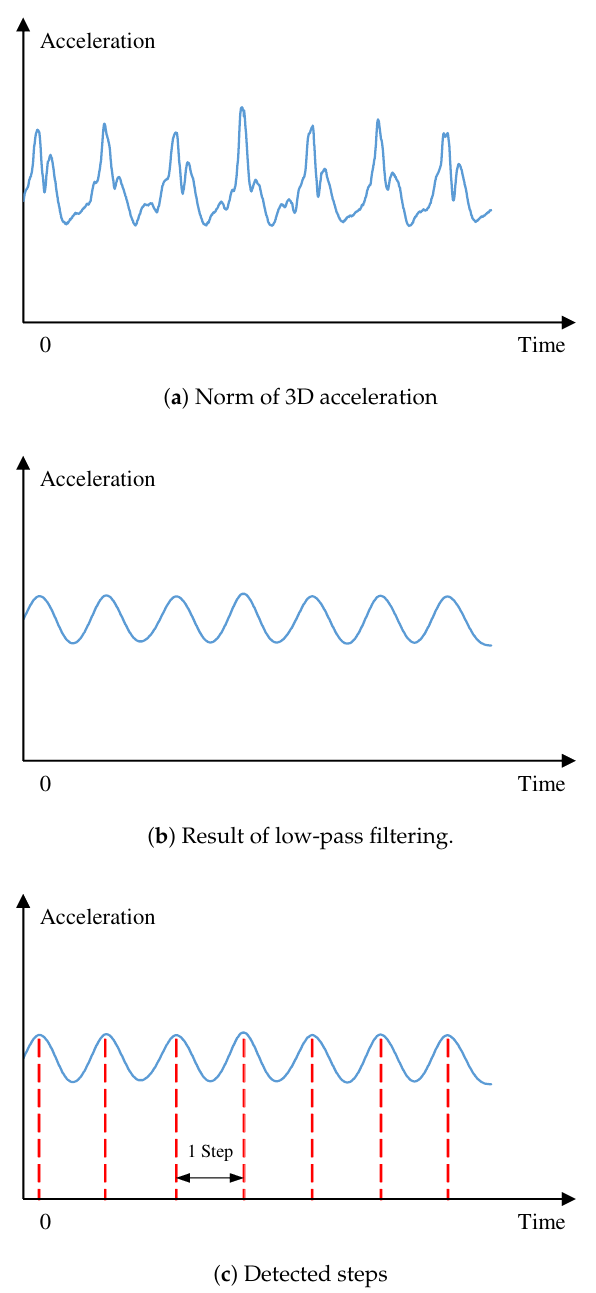
Figure 4. Step-detection